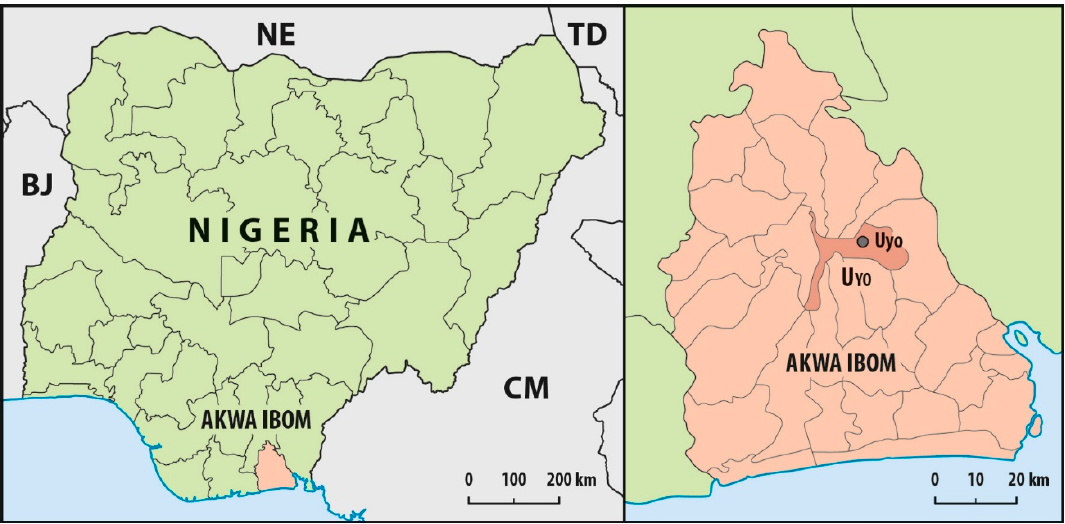
Figure 1. Map of Nigeria showing Akwa Ibom State, and map of Akwa Ibom State showing Uyo (Source: Ministry of Land Surveying, Uyo). (Source: Ministry of Land Surveying,